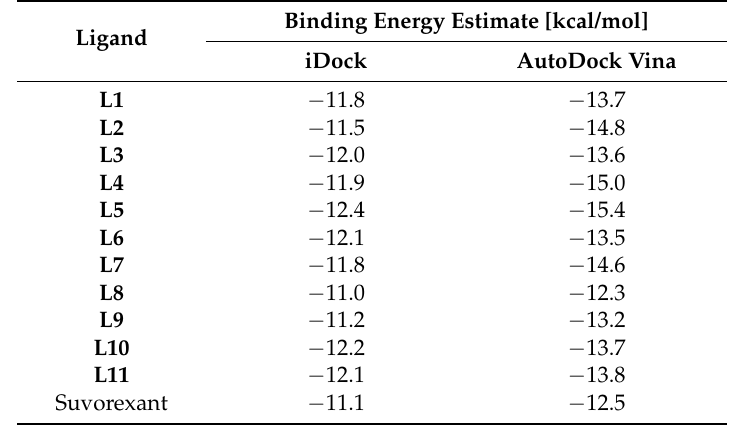
Table 2. Binding energy estimates predicted by iDock and AutoDock Vina 1.1.2 software. The ligand molecules were docked in a model of orexin receptor 2(OX2R) available under PDB ID: 4S0V in the online rcsb.org database.